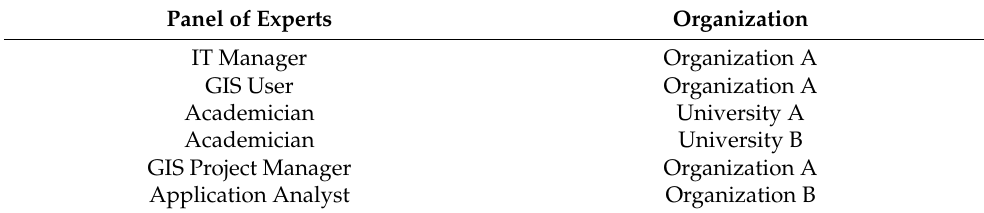
Table 2. Panel of